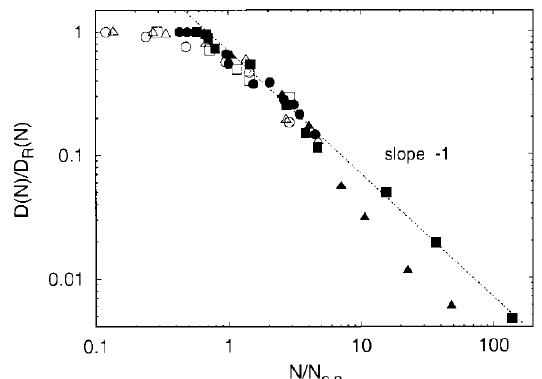
Figure 4. Scaled diffusion coefficient D ( N ) / D R ( N ) vs. scaled chain length N / N e for poly(styrene) ( M e = 14600, T = 485 K, (filled circles) [46], poly(ethylene) ( M e = 870, T = 448 K, filled squares) [52], PEB2 ( M e = 992, T = 448 K, filled triangles) [49], bead-spring Kremer-Grest model ( N e = 72, open triangles), the bond-fluctuation model for φ = 0.5, ( N e = 30, open squares) [91], and tangent hard spheres at φ = 0.45 N e = 29, open circles) [87]. All data are scaled with N e from the plateau modulus or with 2.25 N e from g 1 ( t ) . Reprinted from [92] with permission from